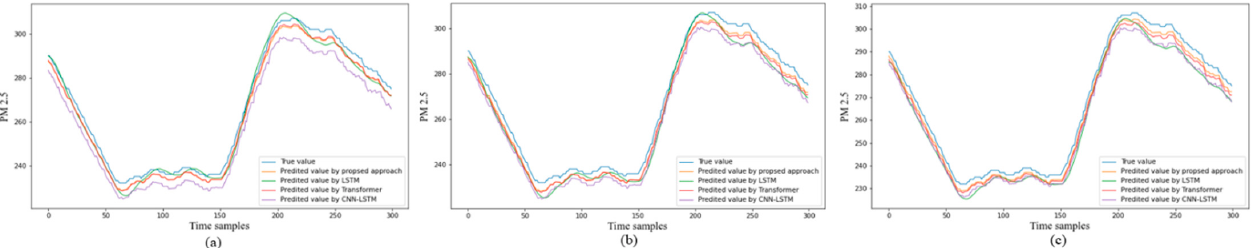
Figure 8. Fitting trends of model for 5 min ahead prediction for ( a ) 20 epochs, ( b ) 30 epochs, ( c ) 40 epochs.